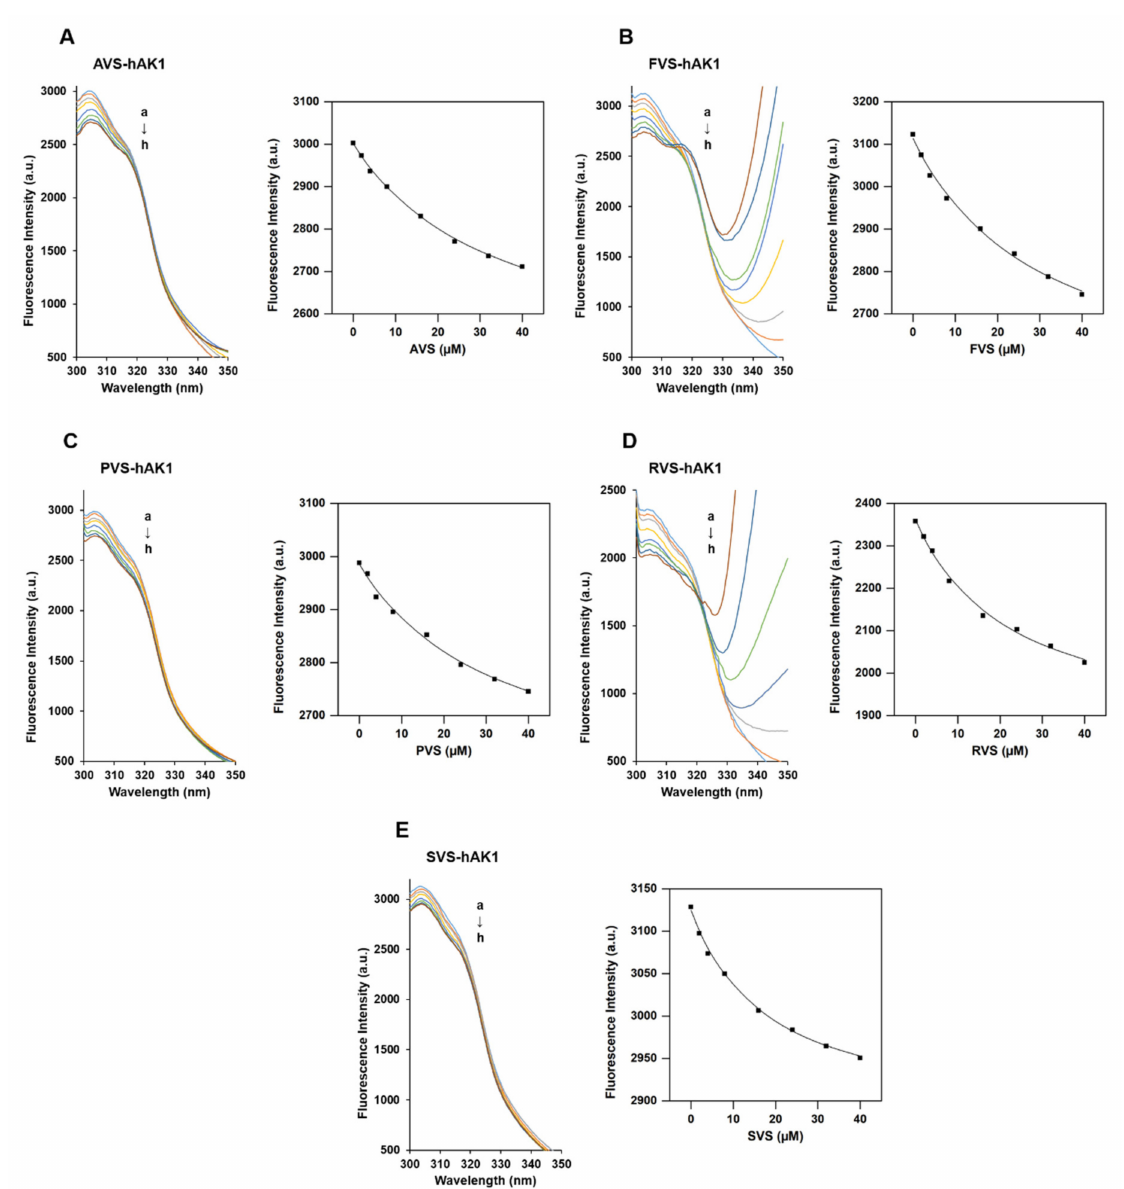
Figure 3. The fluorescence quenching of hAK1 in the presence of ( A ) atorvastatin, ( B ) fluvastatin, ( C ) pravastatin, ( D ) ro- suvastatin and ( E ) simvastatin at 37 ◦ C. (left) Emission spectra of hAK1 in the presence of statin, (right) dependence of fluorescence intensity on statin concentration. The concentration of hAK1 was 2 µ M. The concentrations of the five statins from a to h were 0, 2, 4, 8, 16, 24, 32 and 40 µ M,